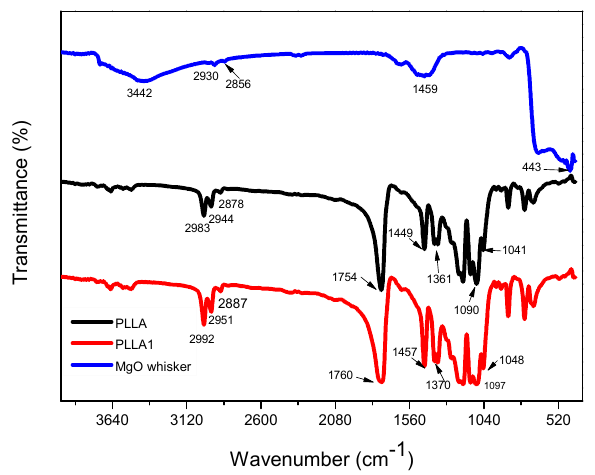
Figure 3. FTIR spectra for PLLA, MgO and PLLA1.